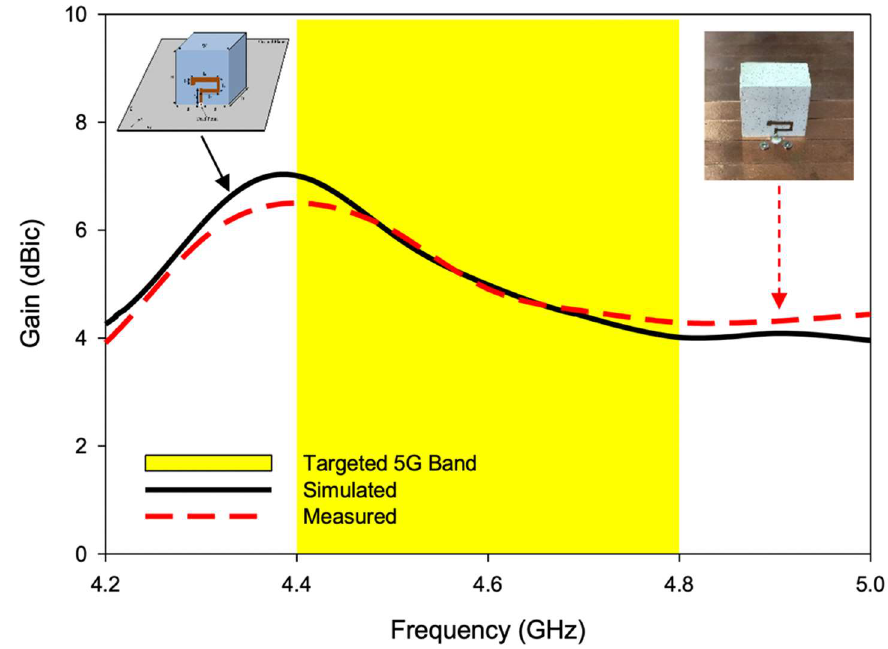
Figure 16. Simulated and measured gain of the CP 5G RDRA. Table 4. Comparison between proposed CP 5G RDRA with recently reported RDRAs in literature.